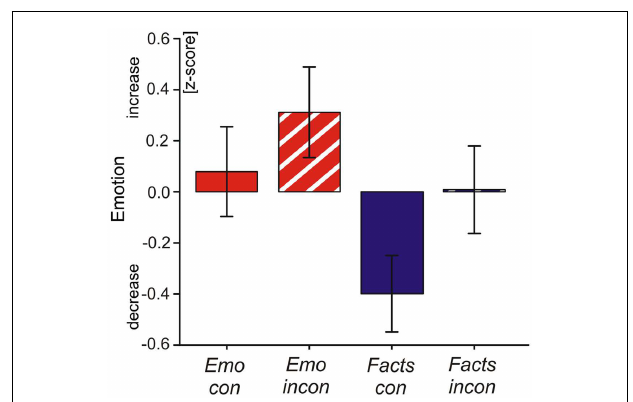
FIGURE 2 |The figure shows standardized subjective ratings ( z -scores) of emotion regulation efficacy by verbalization strategies: emotion admitting (Emo con), emotion denial (Emo inc), fact admitting (Facts con), fact denial (Facts inc) . After the experiment, participants were asked how much each condition subjectively increased or decreased emotional arousal elicited by the pictures on a scale from − 4 to + 4.